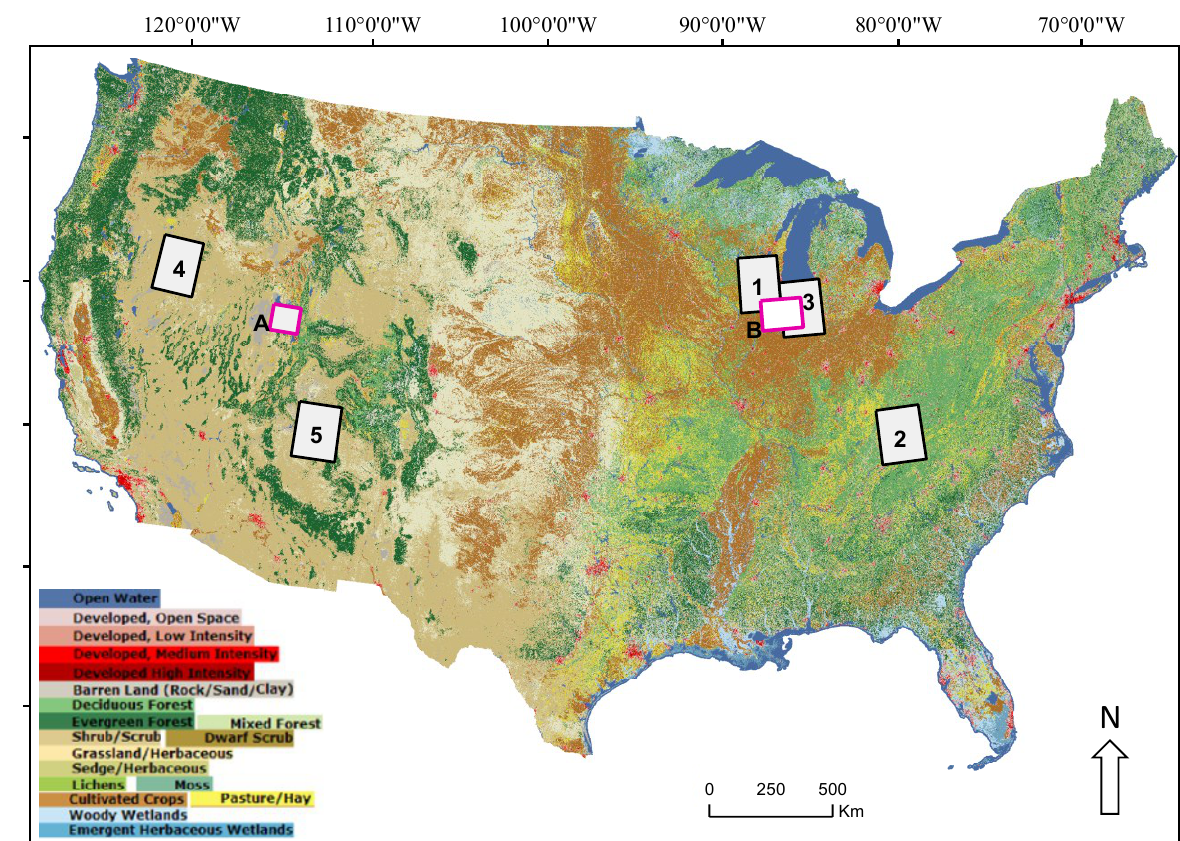
Figure 2. Five select testing sites (black rectangles) and two evaluation sites (pink rectangles) in the conterminous USA (overlaid on the NLCD 2006 land cover